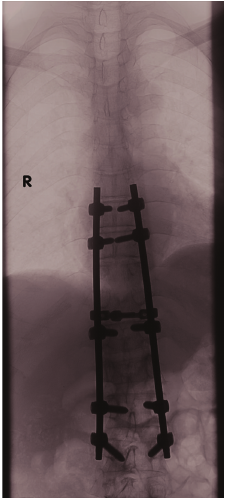
Figure3:Postoperativeplainradiographshowingsegmentalinstru- mentation from T8 to L3